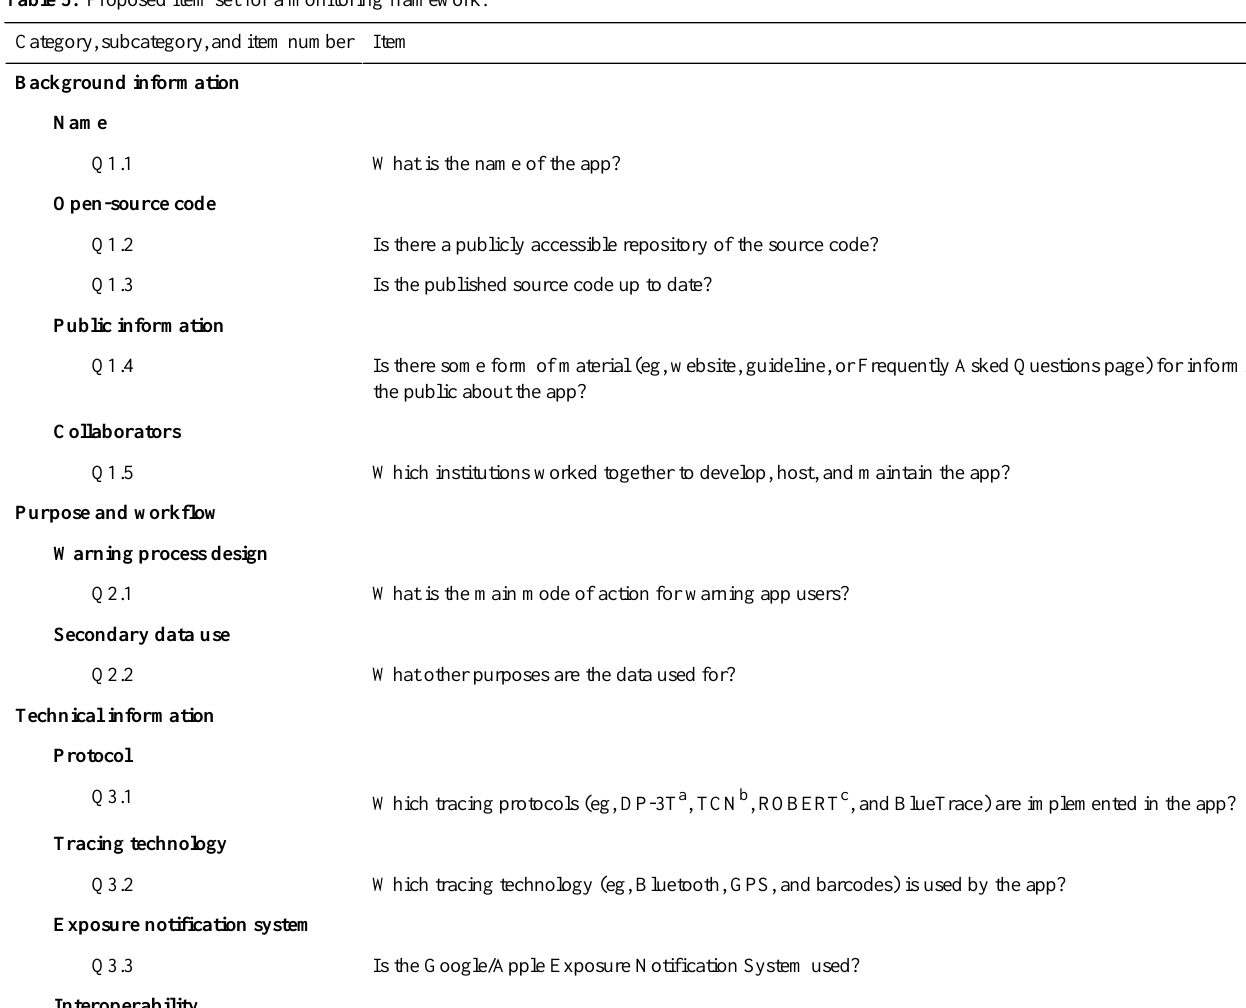
Table 5. Proposed item set for a monitoring framework. ItemCategory, subcategory, and item